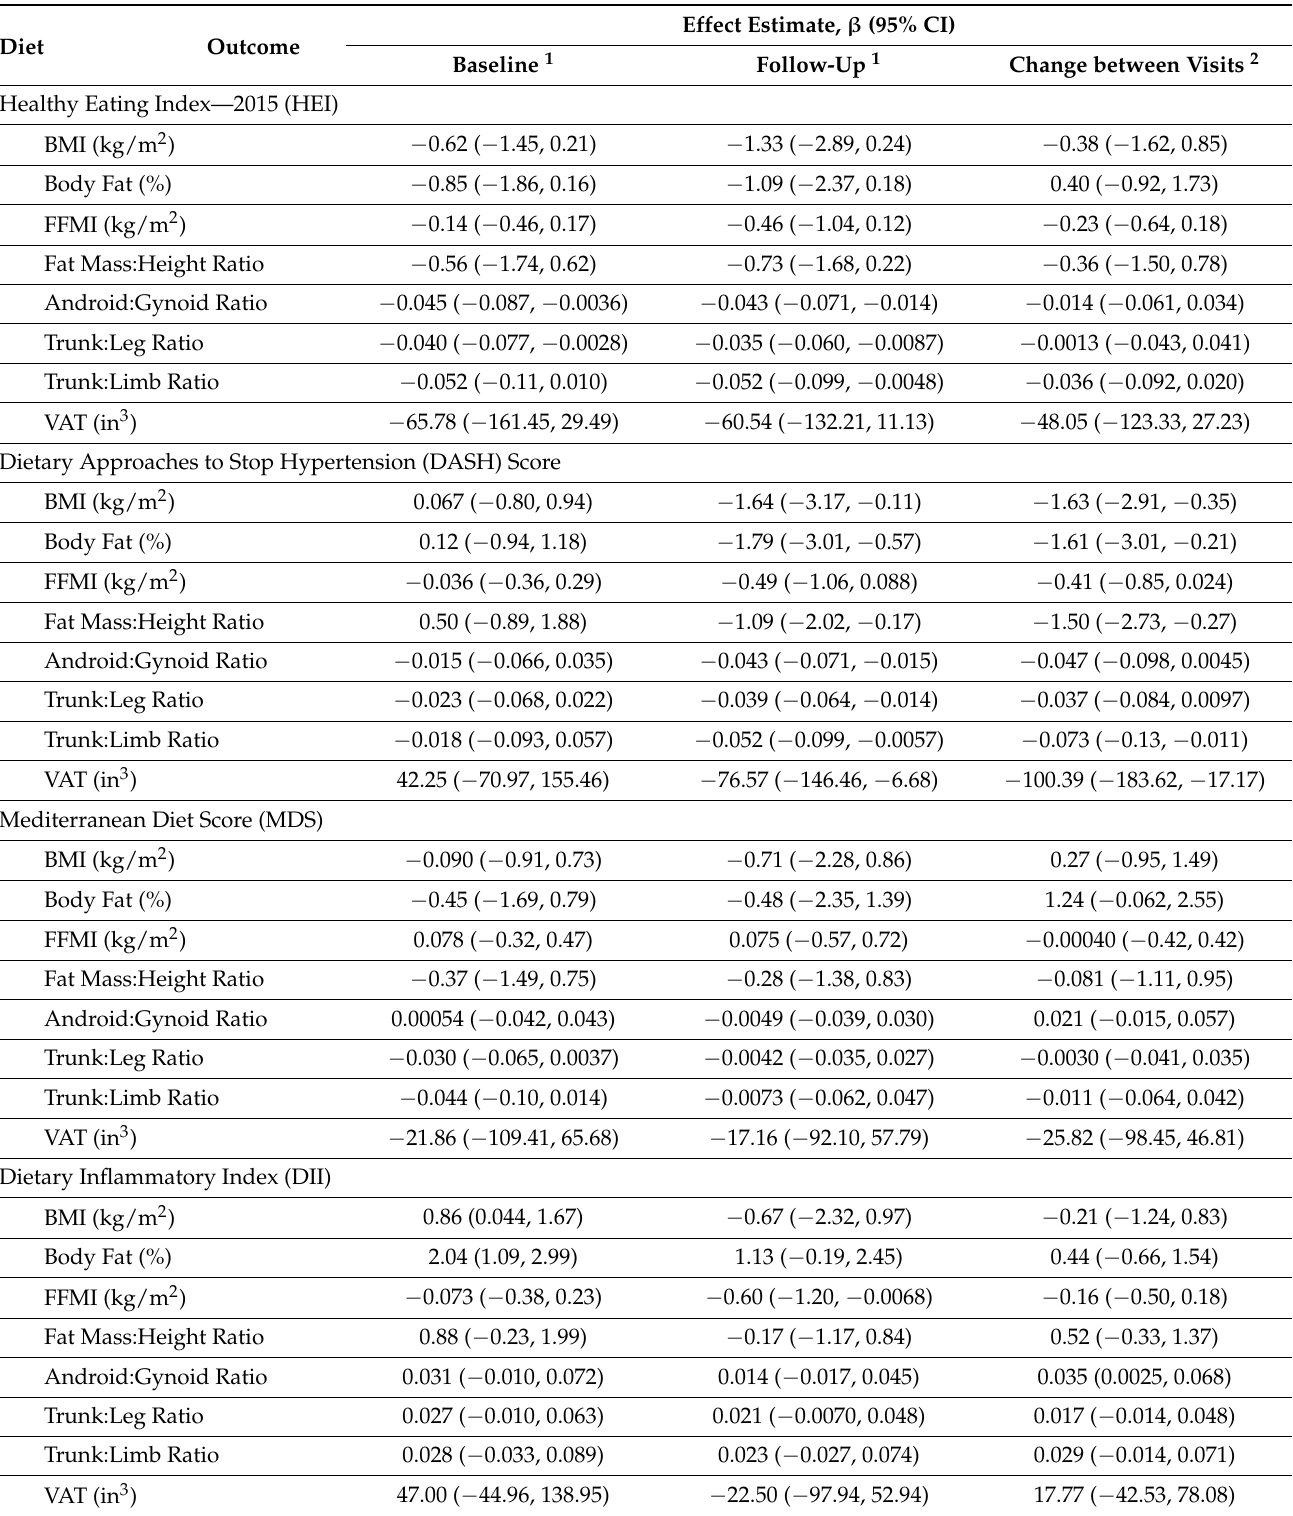
Table 5. Estimated effect size and 95% CI for the effect of 1 standard deviation increase in diet score on body